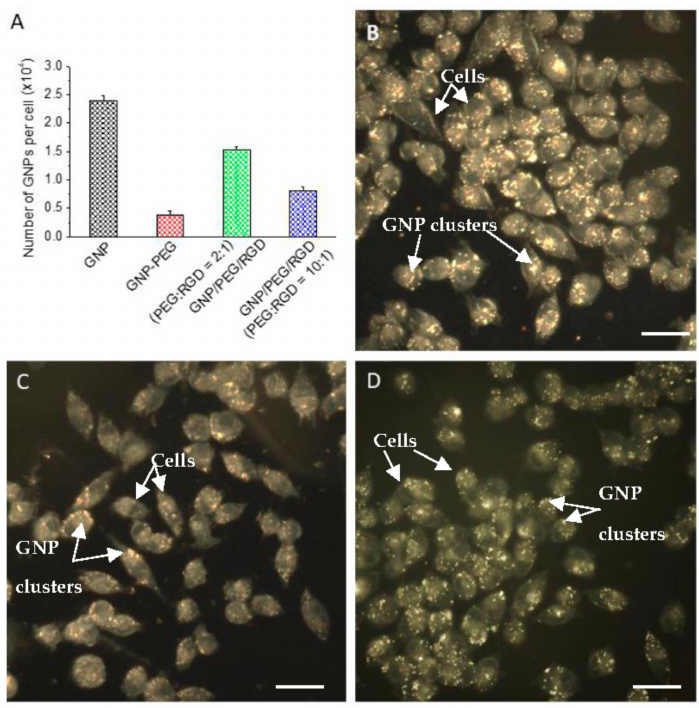
Figure 3. ( A ) Accumulation of GNP constructs in monolayer cells; ( B ) Dark field image of cells incubated with unmodified GNPs; ( C ) Dark field image of cells incubated with GNP-PEG; ( D ) Dark field image of cells incubated with GNP-PEG-RGD (2:1). Scale bar = 10 µ m. PEG = polyethylene glycol; RGD = arginyl-glycyl-aspartic